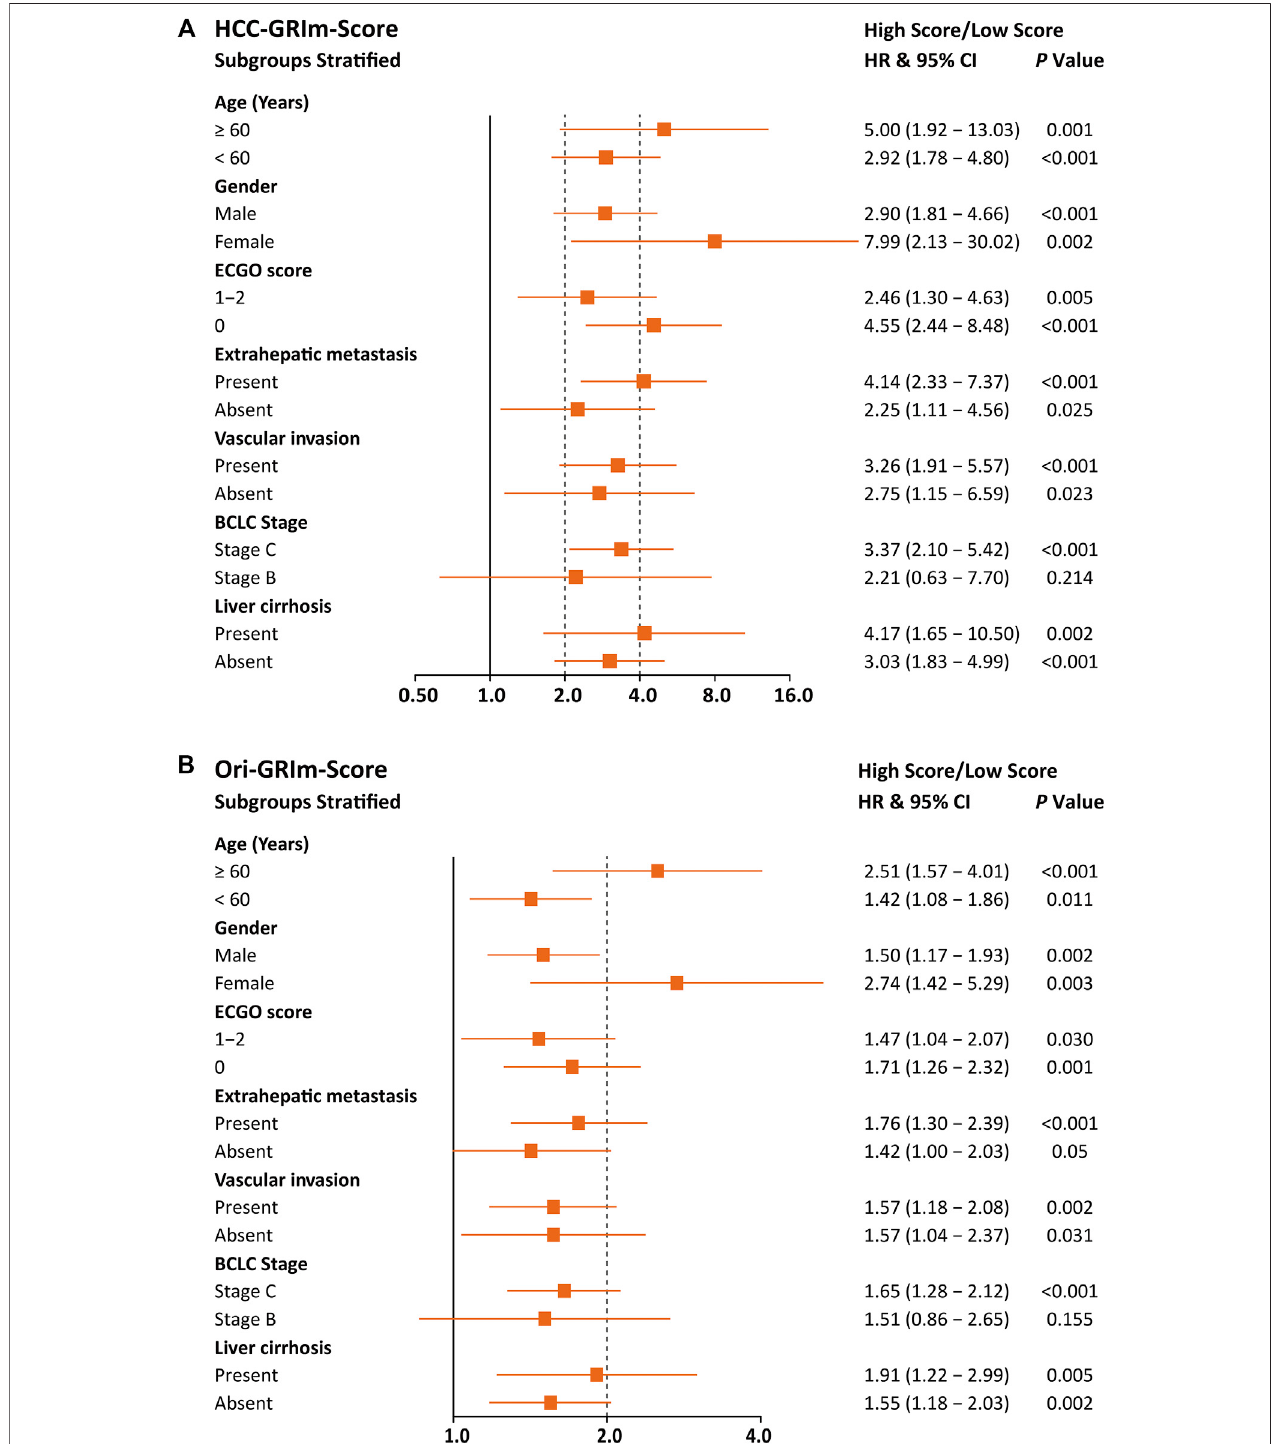
FIGURE 2 | Forest plots strati fi ed by HCC-GRIm-Score (A) and Ori-GRIm-Score (B) . HCC, hepatocellular carcinoma; HR, hazard ratio; CI, con fi dence interval.